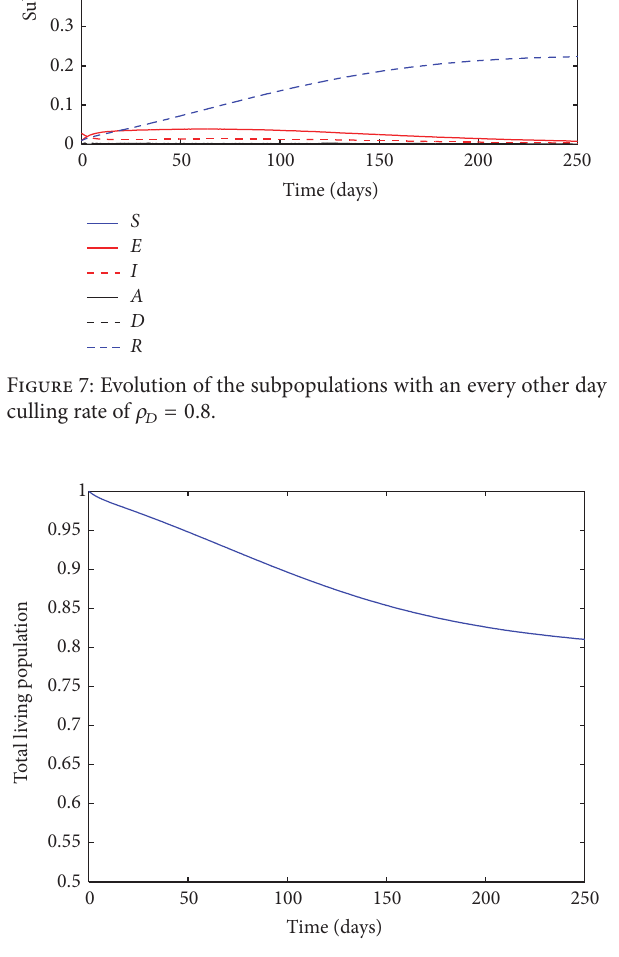
Figure 8: Evolution of the total alive population with an every other day culling rate of 𝜌 𝐷 = 0.8